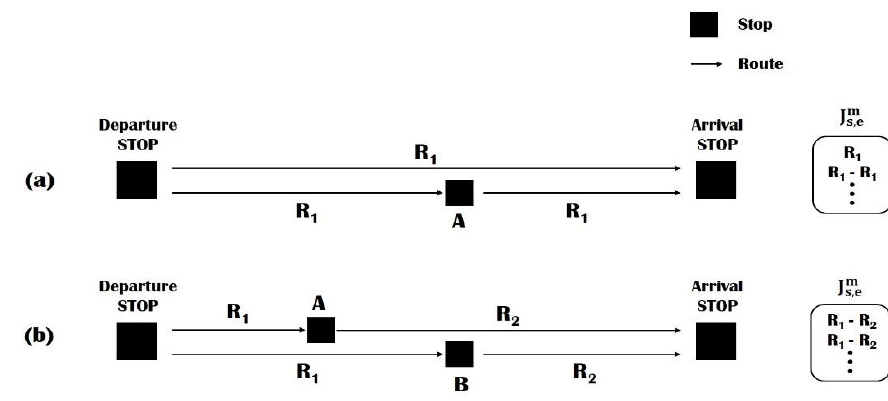
Figure 2. An example of search for similar